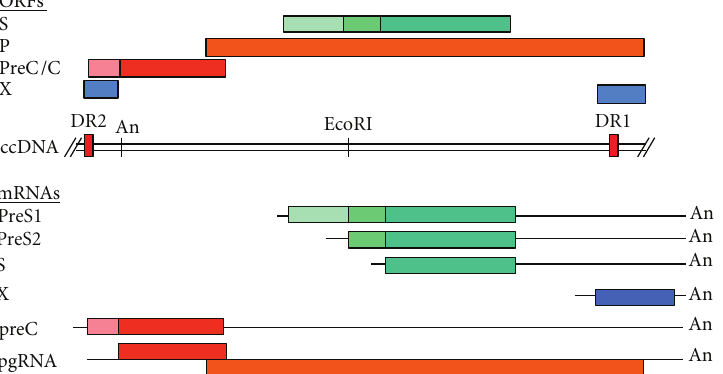
F 1: e closed covalent circular DNA of HBV depicted in linear form and showing positions of the direct repeats (DR) 1 and 2, and the polyadenylation signal (An). e open readings frames encoding for the surface (S), polymerase (P), X and Precore/core proteins are shown above, whilst the RNA transcripts are shown below the cccDNA. e various RNA transcripts terminate at the common polyadenylation signal.